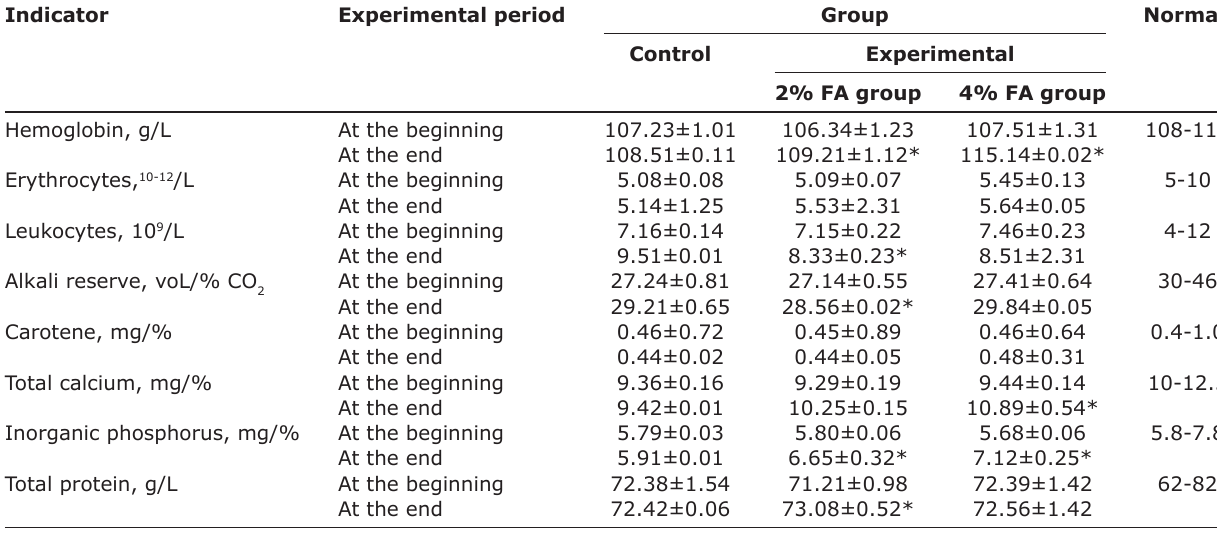
Table-3: Dynamics of hematological parameters of cows’ blood (X±Sx). Indicator